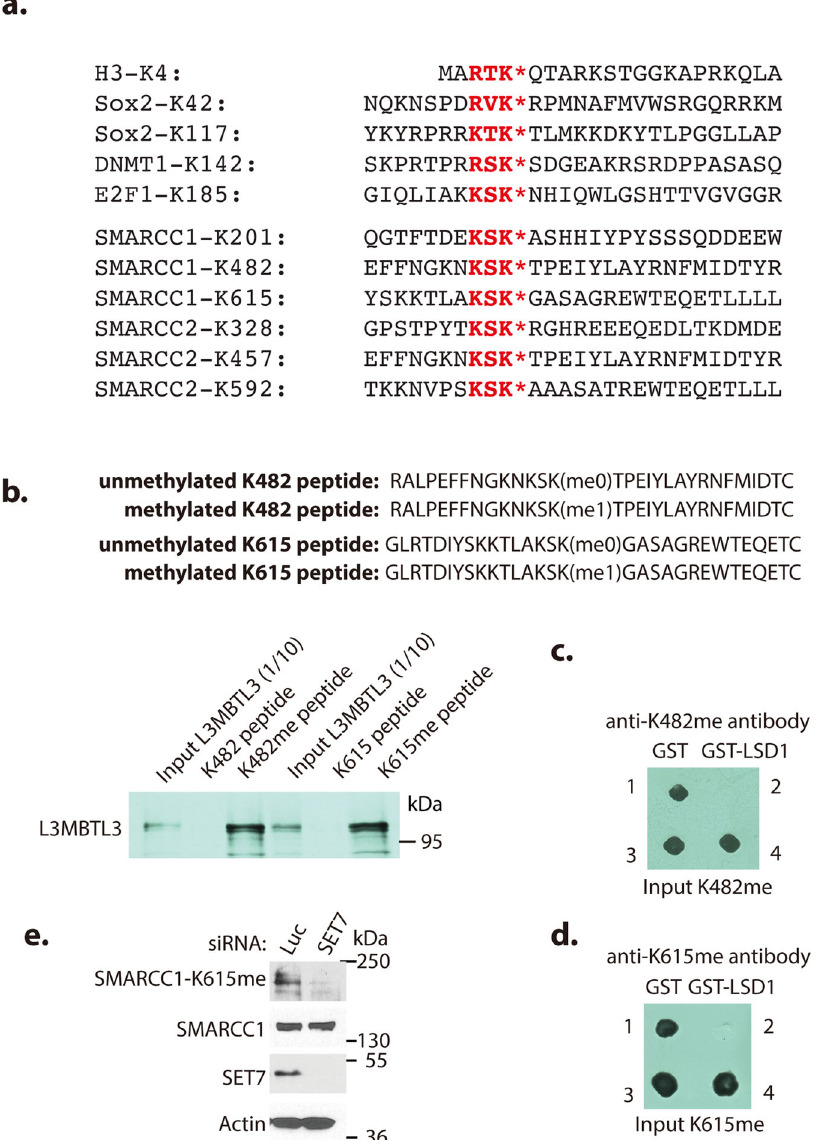
Fig. 3 | L3MBTL3 and LSD1 recognize the methylated K482 and K615 in SMARCC1. a The consensus lysine residues (K*) methylated by SET7 in H3K4-like methylation motifs with the R/K-S/T/V-K* consensus sequences. b L3MBTL3 pre- ferentiallybindstothemonomethylatedK482andK615peptides.Sulfolink-agarose immobilizedSMARCC1peptidescontainingthemonomethylatedK482andK615,or cognateunmethylatedpeptideswereincubatedwith20 μ lofinvitrotranslatedand 35 S-methionine labeled L3MBTL3 for 1h at room temperature. L3MBTL3 binding to the peptide resins was analyzed by autoradiography after protein electrophoresis separation. c , d LSD1demethylatesmethylatedK482andK615inSMARCC1.Puri fi